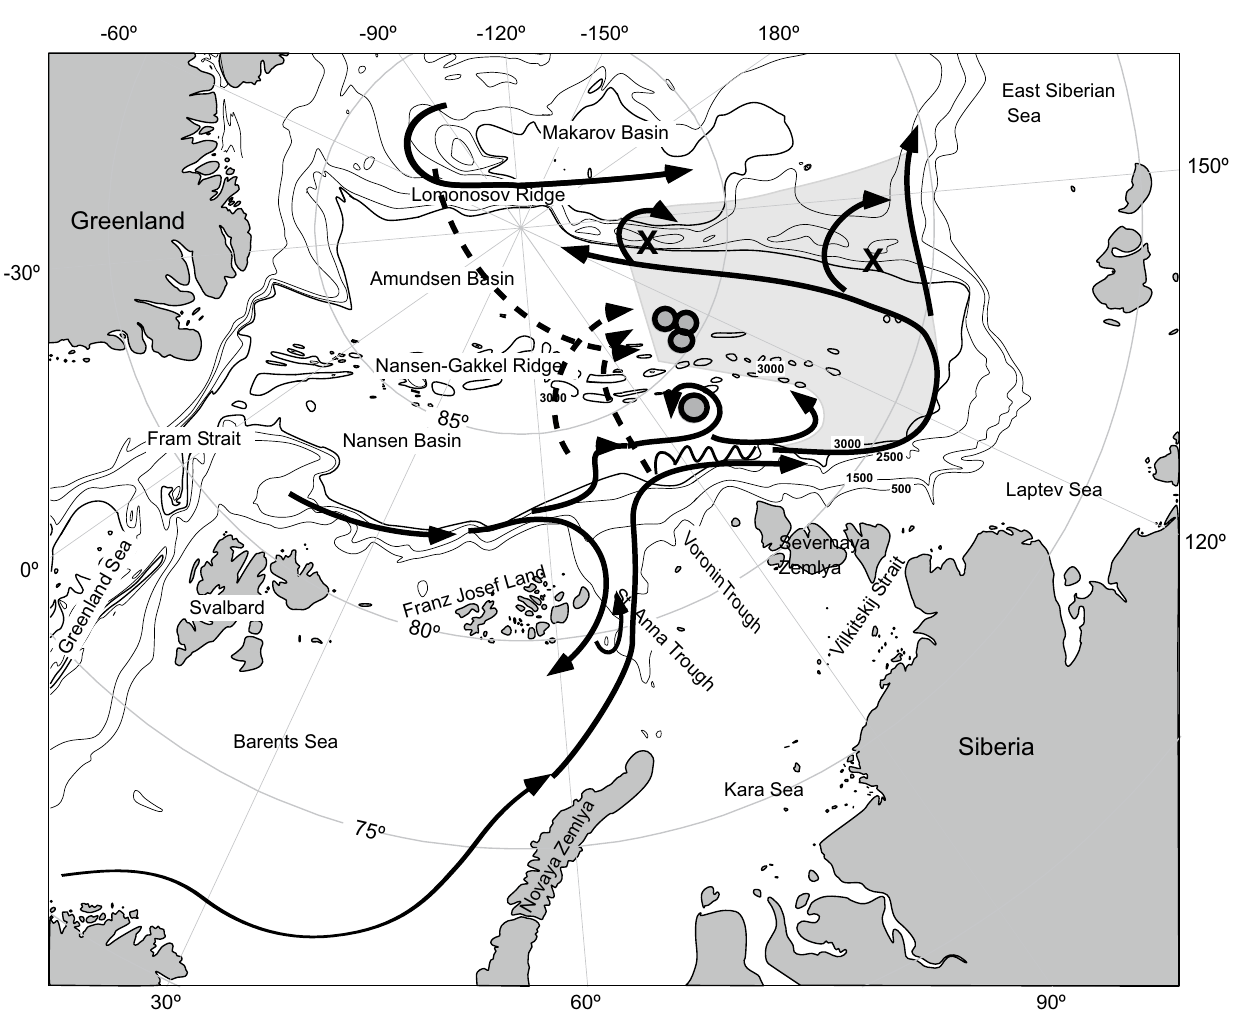
Fig. 16. Distribution of intermediate water masses in the eastern Eurasian Arctic. Solid line arrows display the flow of the Fram Strait branch of Atlantic water, the Barents Sea branch, and, east of the confluence and mixing area, the flow of the mixture of both. The grey filled circles denote eddy-like structures with water originating from the Makarov Basin, the Fram Strait branch and the Barents Sea branch. The dashed arrows do not show pathways, but rather connect the anomalous water parcels with their area of origin. The light grey shading shows the region dominated by the mixed water type. The heavy line arrow in the Makarov Basin denotes the flow of Upper Polar Deep water (Rudels et al., 1994). Crosses denote the position of elevations of the Lomonosov Ridge of less than 1000m in water depth (Perry and Fleming, 1986), possibly steering the cross-ridge flow of intermediate